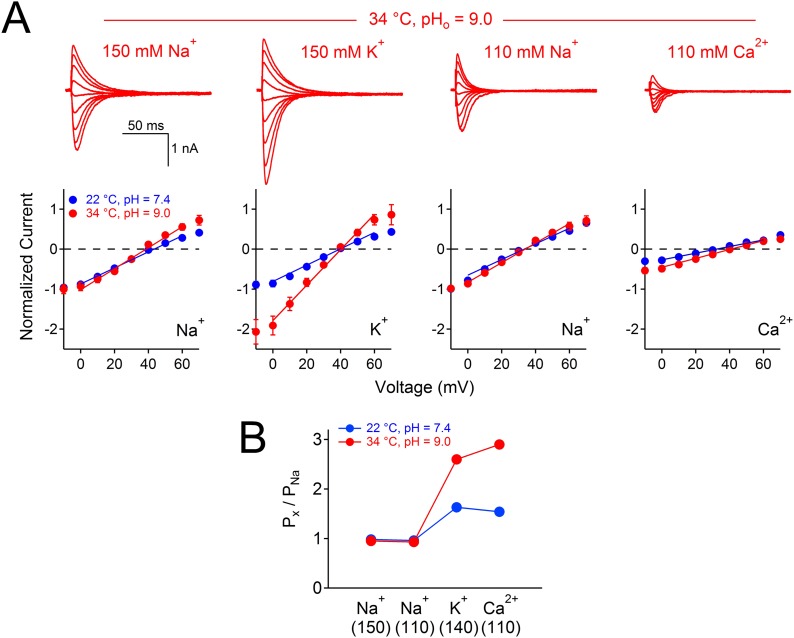
The effect of temperature and pH on NsvBa selectivity.(A) Top, Representative NsvBa current traces recorded at 34⁰C under different extracellular cationic conditions with a pH = 9. Currents were activated by increasing potentials from −10 mV to 70 mV from a holding potential of −140 mV. Bottom, Corresponding current–voltage relationships measured under the conditions listed above (n = 4 or 5 for each condition, Error = ±SEM). Peak inward currents were normalized to the Na+ current measured either in 110 or 150 mM extracellular solution. Erev was calculated by fitting the current from 0 mV to 60 mV to a linear equation, and determining the potential at zero current. When corrected for liquid junction potential differences in the salines, Erev under these conditions were 40 mV for 150 mM Na+; 36 mV for 110 mM Na+; 41 mV for 110 mM Ca2+ and 43 mV for 150 mM KCl. (B) The calculated relative permeability for cations measured at 22⁰C and 34⁰C.